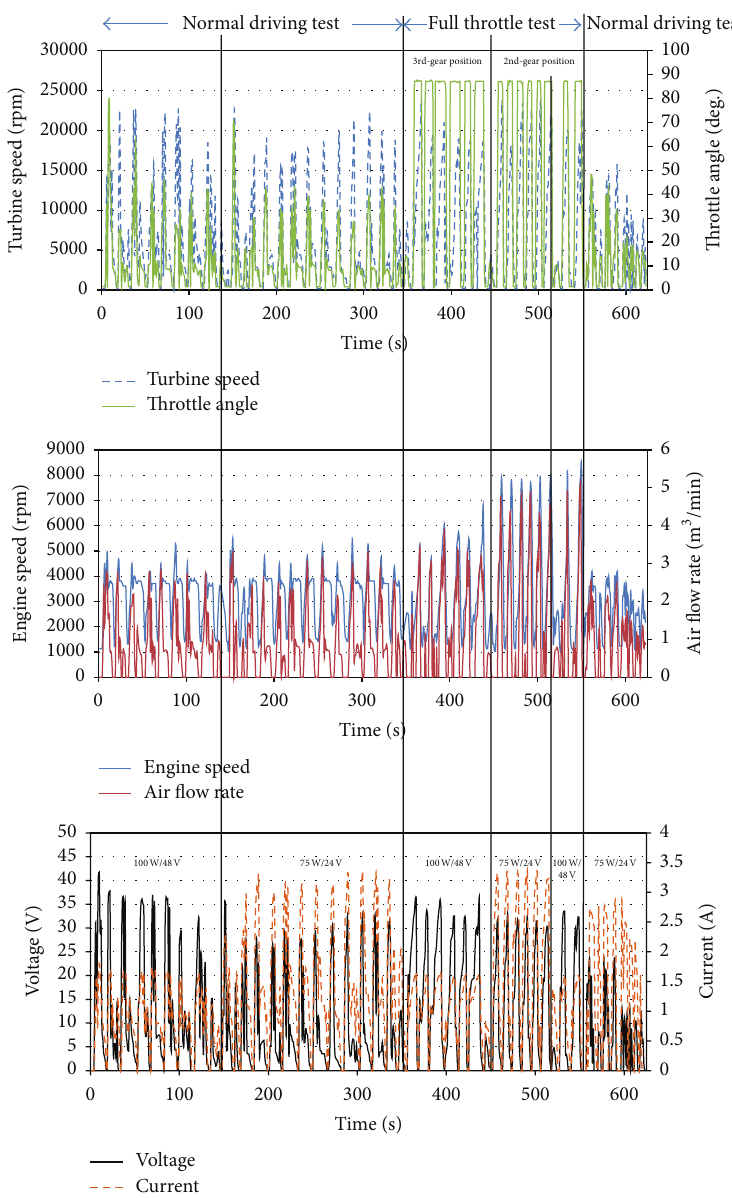
Figure 6: The measured data from the experimental vehicle with